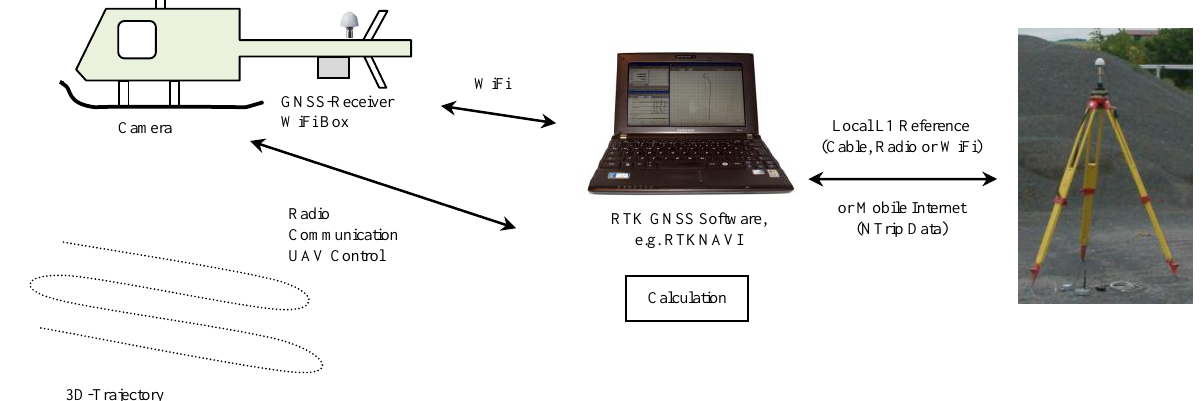
Figure 4. RTK GNSS Low-cost System based